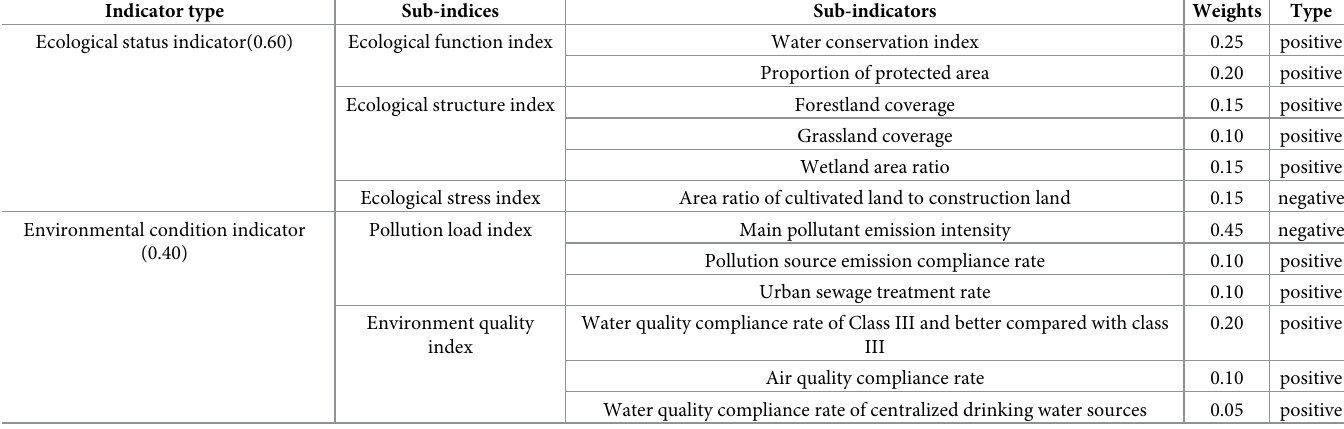
Table 1. Index systems for evaluating water conservation functions (before improvement). Indicator type Ecological status indicator(0.60)